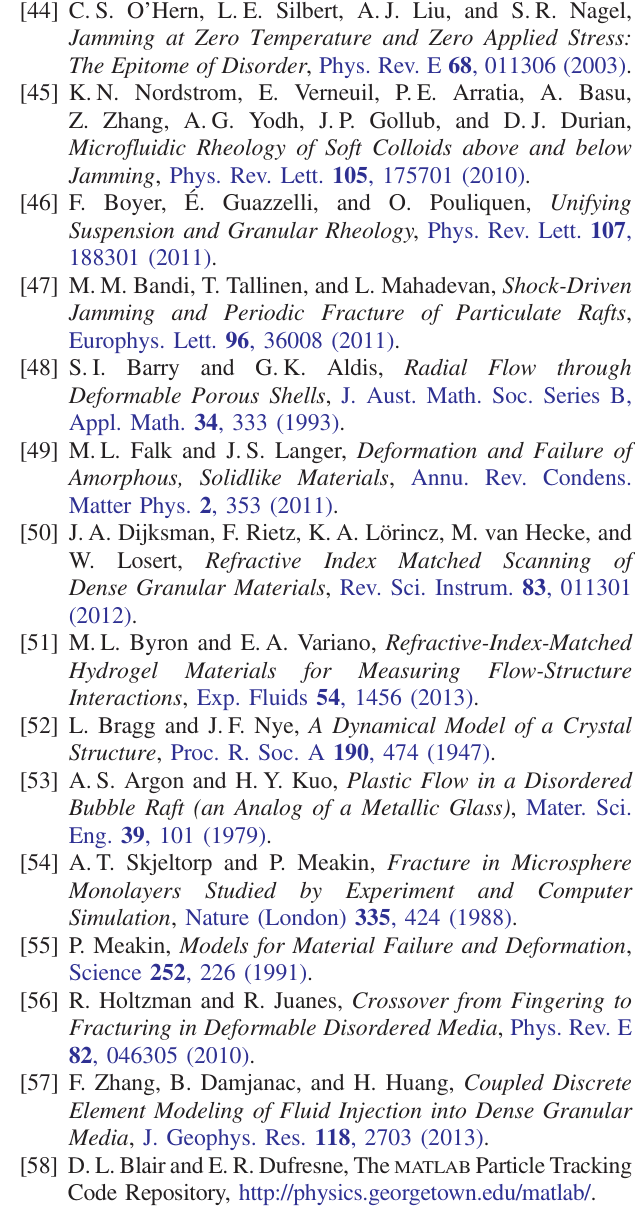
Fingers on Jammed Systems: New Fluidlike Patterns Arising in Grain-Grain invasion Experiments , Phys.